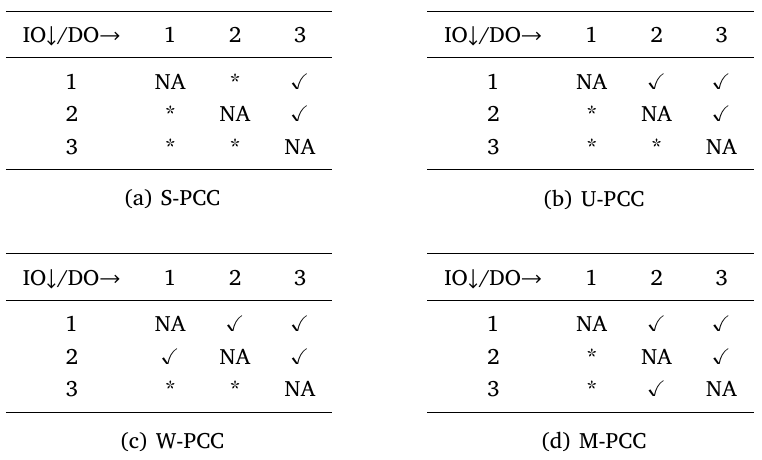
Table 4: Attested variants of the